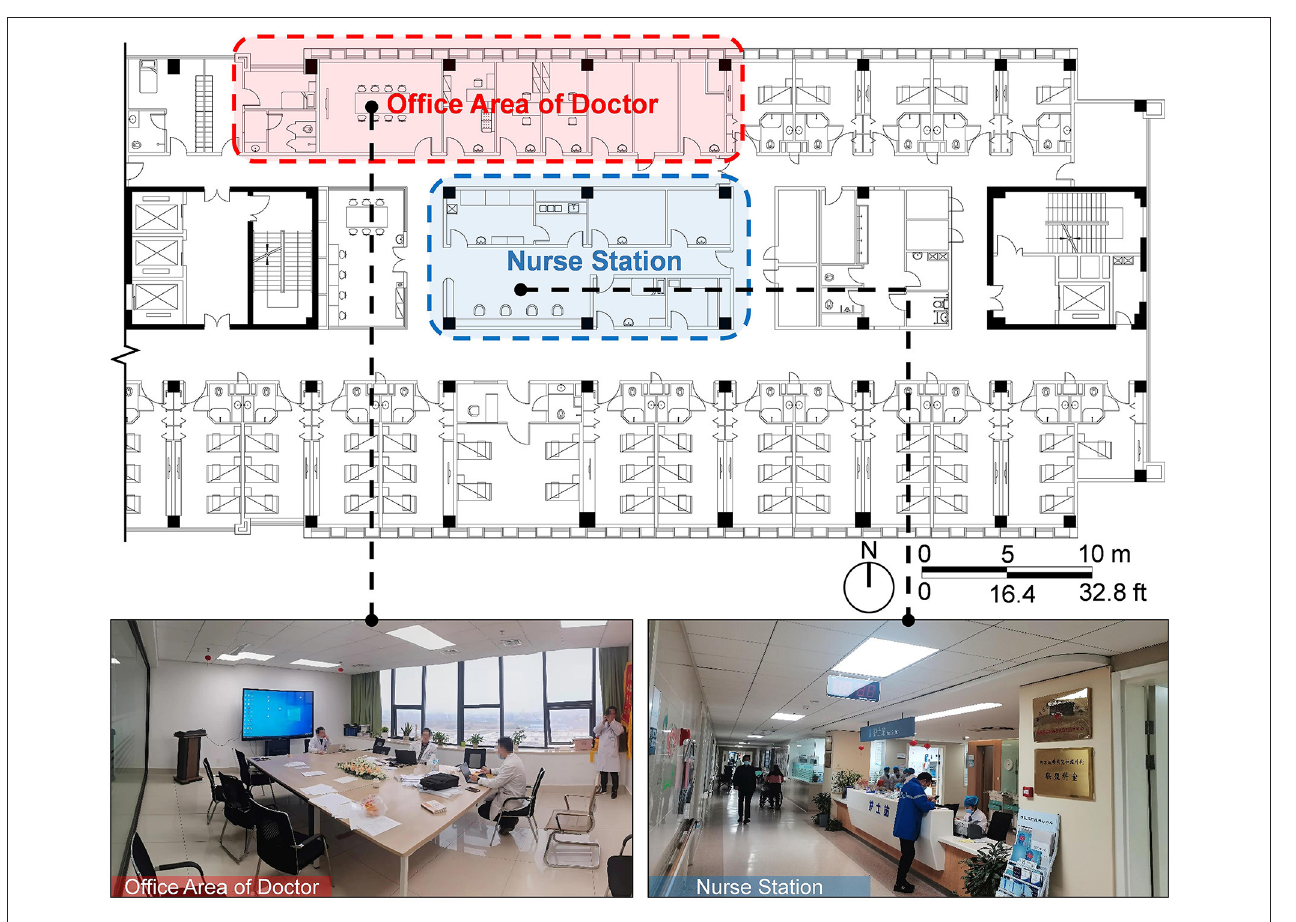
FIGURE 2 | Layout and reality images of the ward where doctors and nurses participated in this study were